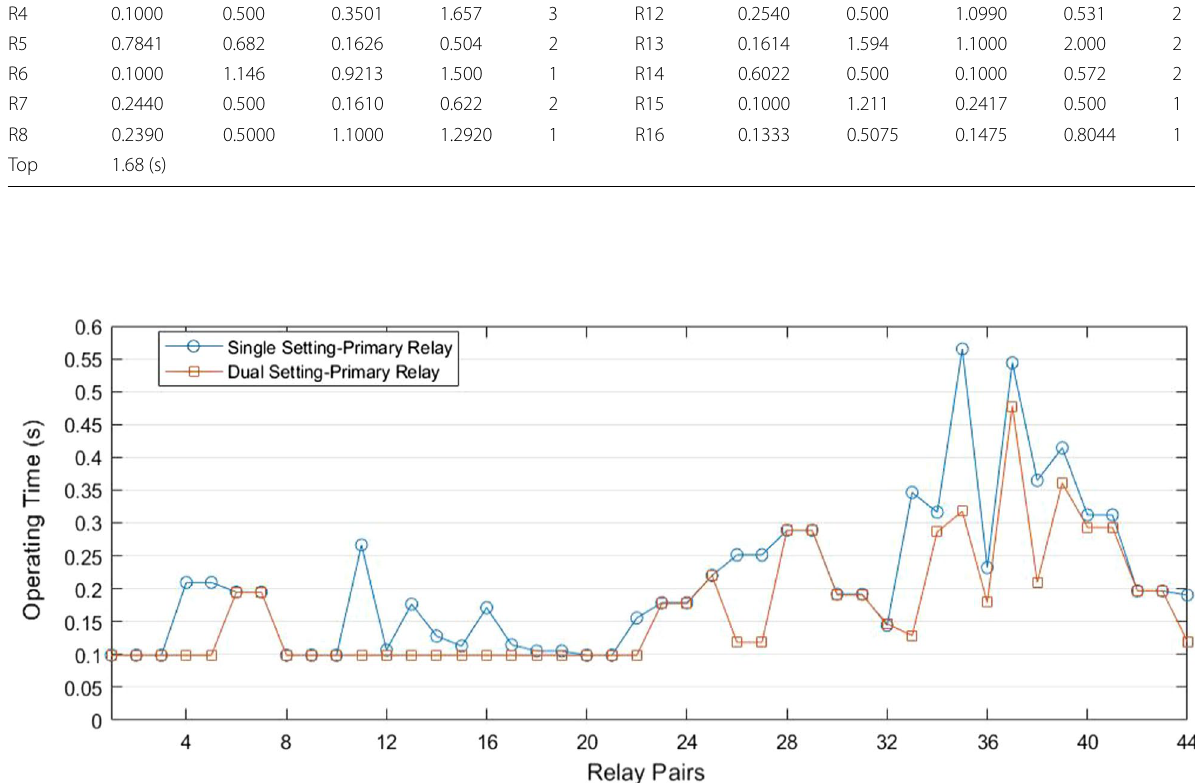
Fig. 10 Primary relay operating time using single and dual setting DOCR for common relay